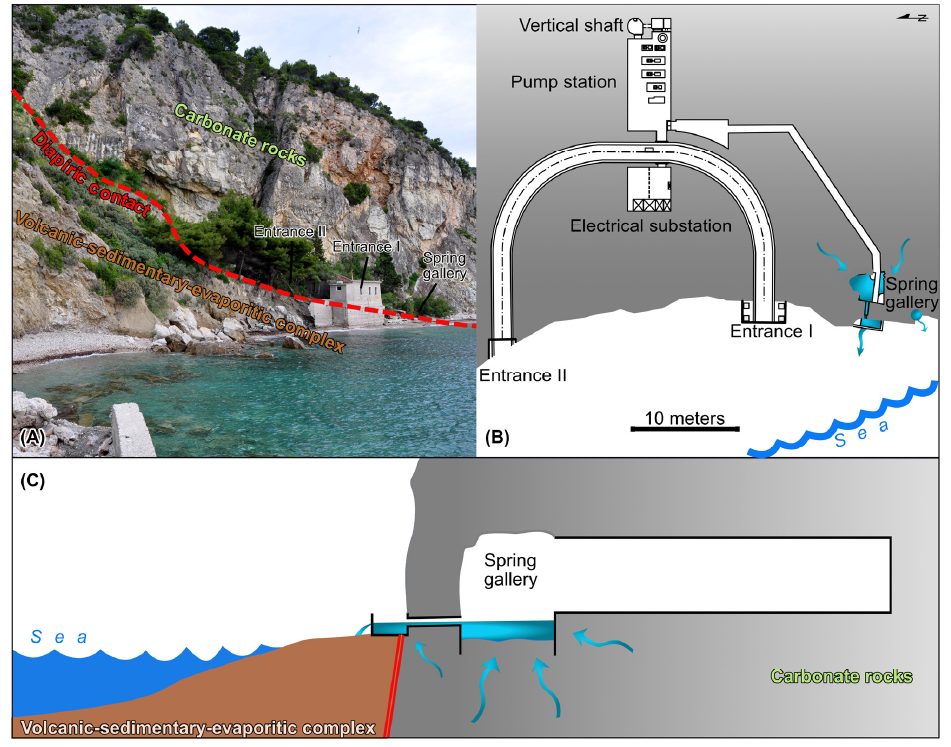
Figure 2. Pizdica karst spring. ( A ) Contact of the volcanic–sedimentary–evaporitic complex with carbonate rocks and the sea (the spring is located behind the building). ( B ) Scheme of the extraction site constructed in the carbonate rock by mining for the purpose of nuclear wartime water supply in the 1950s, which is still in use. ( C ) Illustrative cross-section. The Korita pumping site includes a total of six wells, five of which are in use. The total designed pumping yield was 27 L/s, which was increased to 40 L/s after research and optimization. Water has been supplied from these wells since the late 1960s, when the first wells were drilled after bulk investigations that involved geological, hydrogeological, and geophysical (geoelectrical sounding) research, as well as test drilling, pumping tests, and hydrochemical interpretations (Figure 3). Terzi ć [16] lists the numerous unpublished technical reports, which exist from that time.